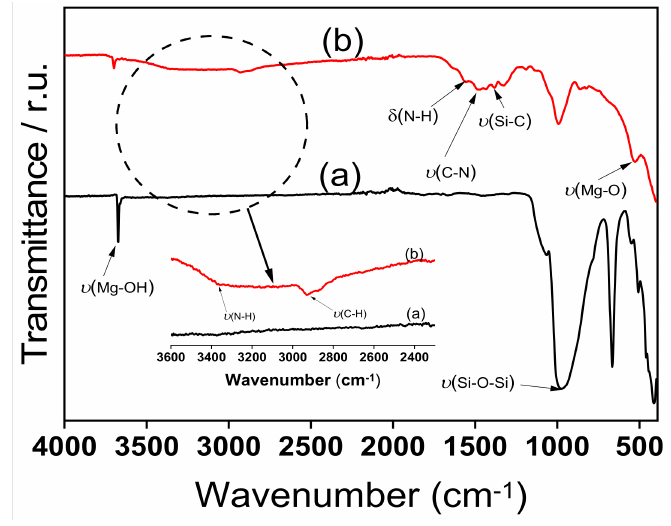
Figure 2. Fourier transform infrared (FTIR) spectra of: ( a ) Nat-Talc, and ( b ) TalcNH 2 .